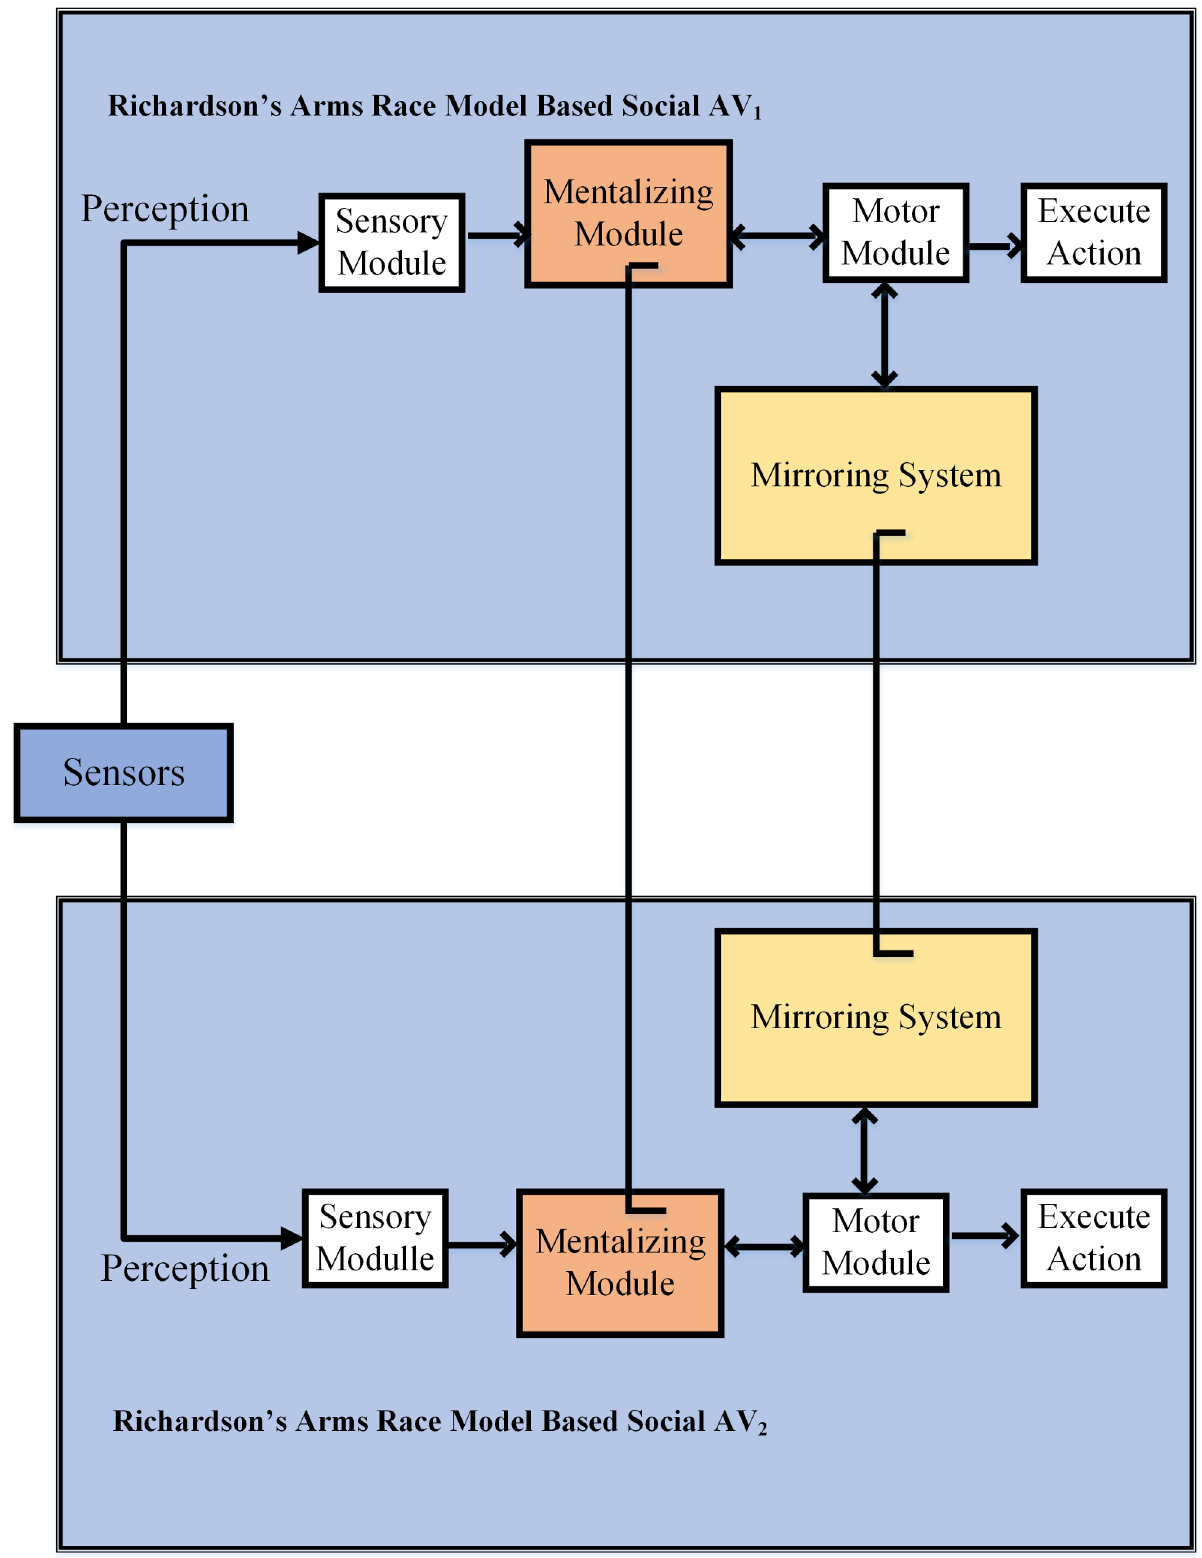
Fig 2. AVs installed with proposed social agents interacting socially with each other. https://doi.org/10.1371/journal.pone.0186103.g002 PLOS ONE | https://doi.org/10.1371/journal.pone.0186103 October 17,